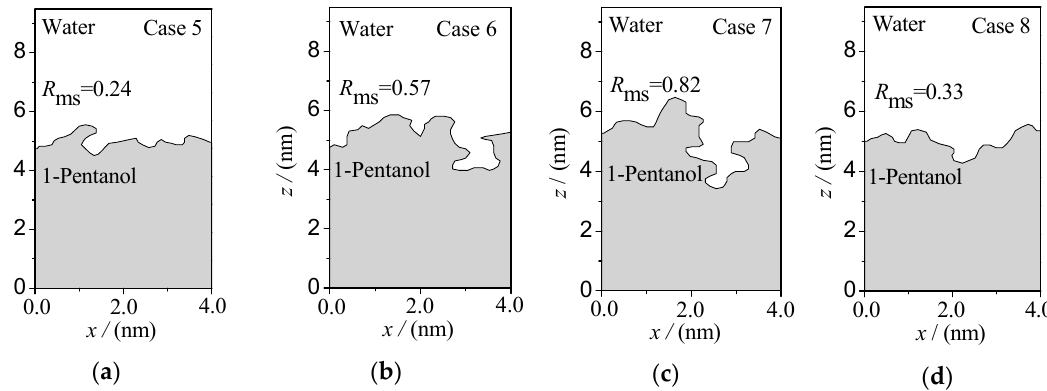
Figure 7. Interface morphology of the 1-pentanol–NaCl aqueous solution system with di ff erent concentrations of ions: ( a ) Case 5; ( b ) Case 6; ( c ) Case 7; ( d ) Case 8.